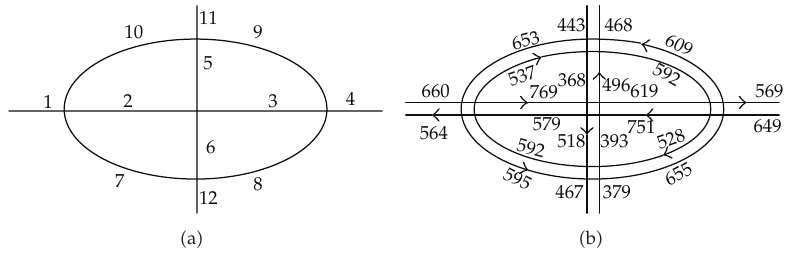
Figure 4: The number and the tra ffi c flow of links.